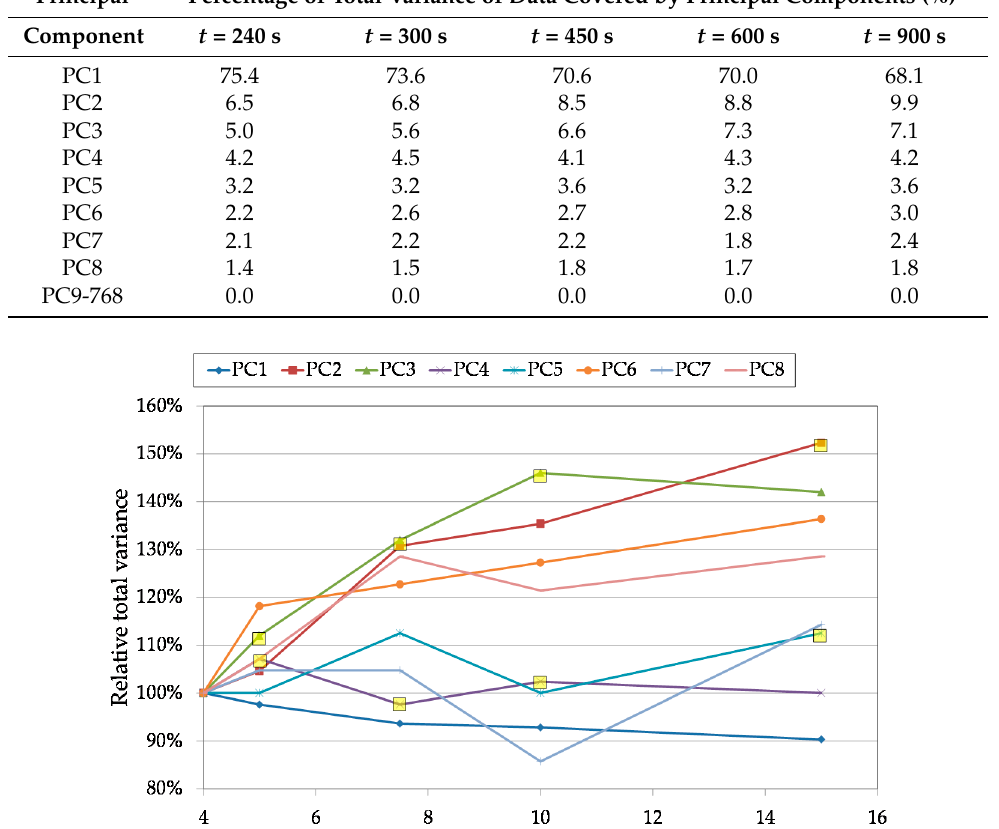
Table 1. Percentage of total variance of data covered by principal components calculated for different measurement times.